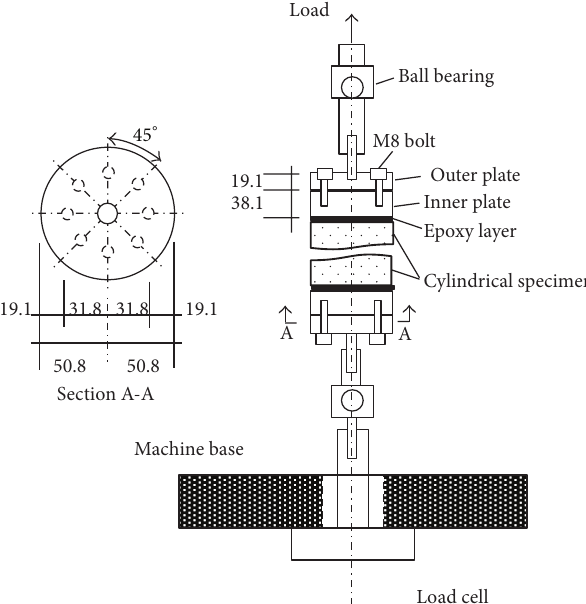
Figure 1: Test setup of the proposed direct tension test for 101.6mm diameter and 203.2 mm height cylinder (mm).